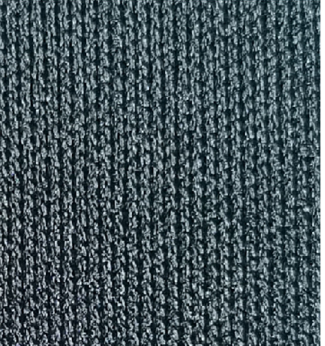
Figure 1. All-polyester knitted fabric.